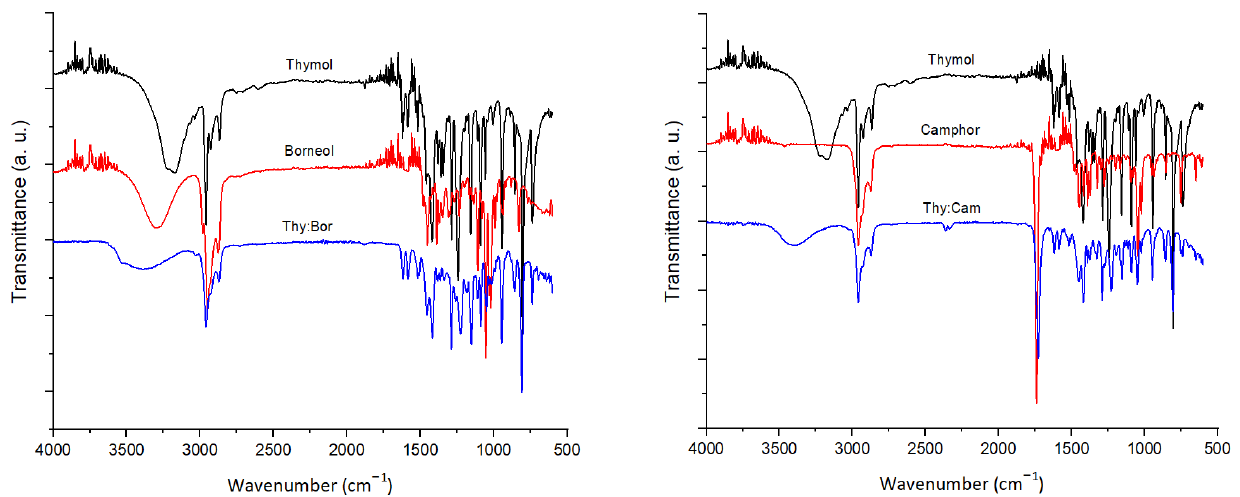
Figure 1. FTIR spectra of the pure terpenes and eutectic systems.